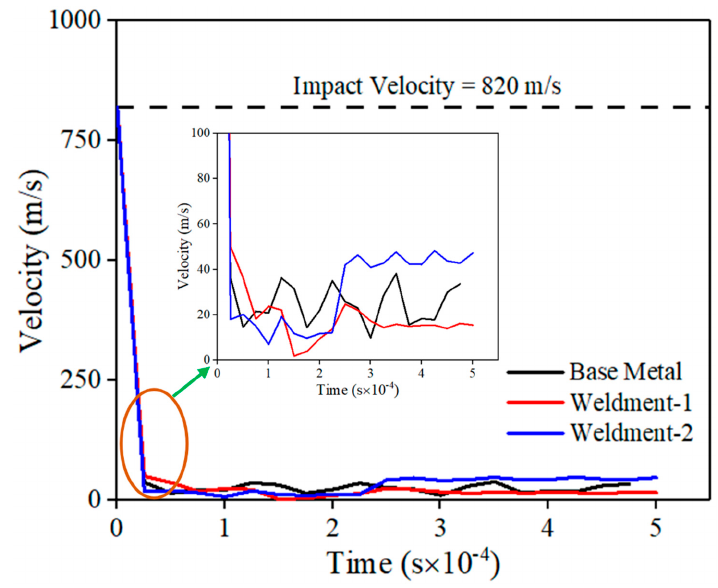
Figure 11. Velocity vs. Step time.